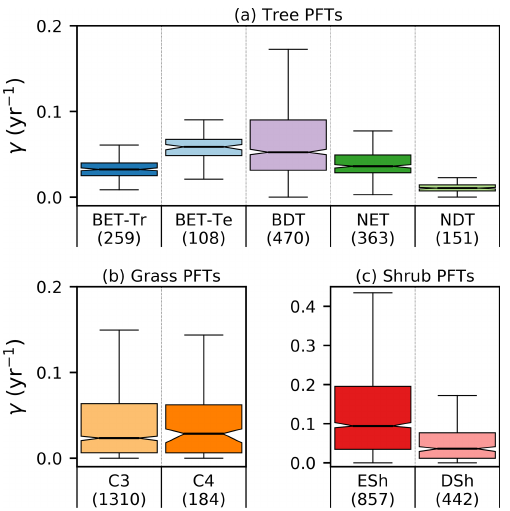
Figure 7. Diagnosed mortality rates for (a) trees, (b) grasses, and (c) shrubs in the top quartile of coverage. Notches within the box represent the confidence bounds of the median. The confidence bounds are estimated using a bootstrap method. Bracketed numbers represent the number of grid points.